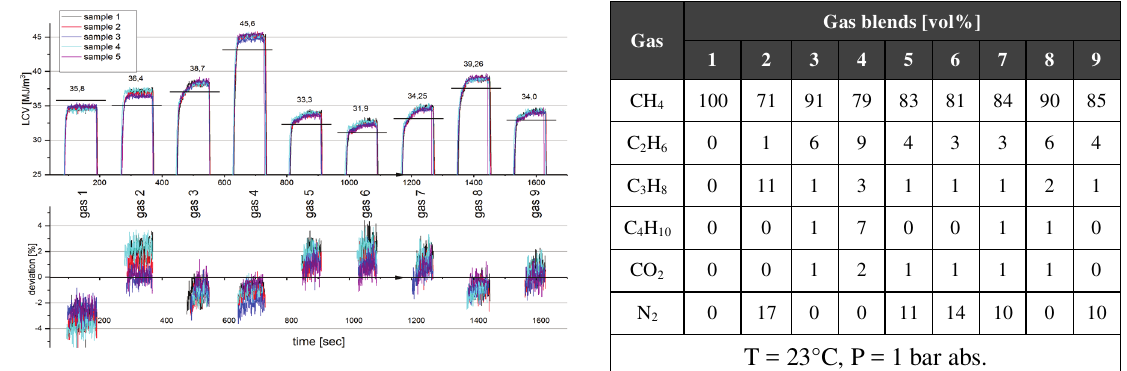
Fig. 7. Testing of synthetic gas blends to predict the lower calorific